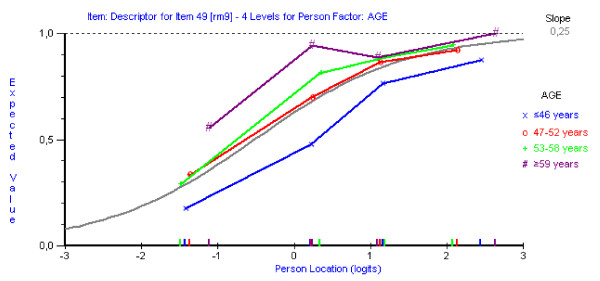
Differential Item Functioning for item RDQ 9 "I get dressed more slowly than usual because of my back" by age. (n = 266).